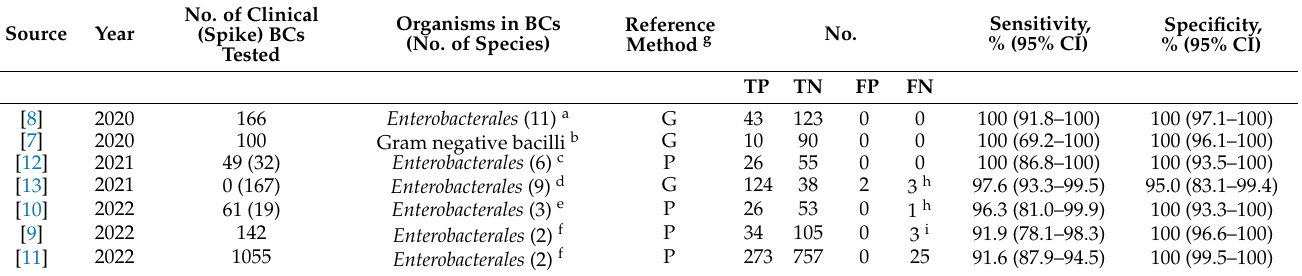
Table 4. Published literature on direct testing of positive blood cultures using an NG-Test CTX-M MULTI